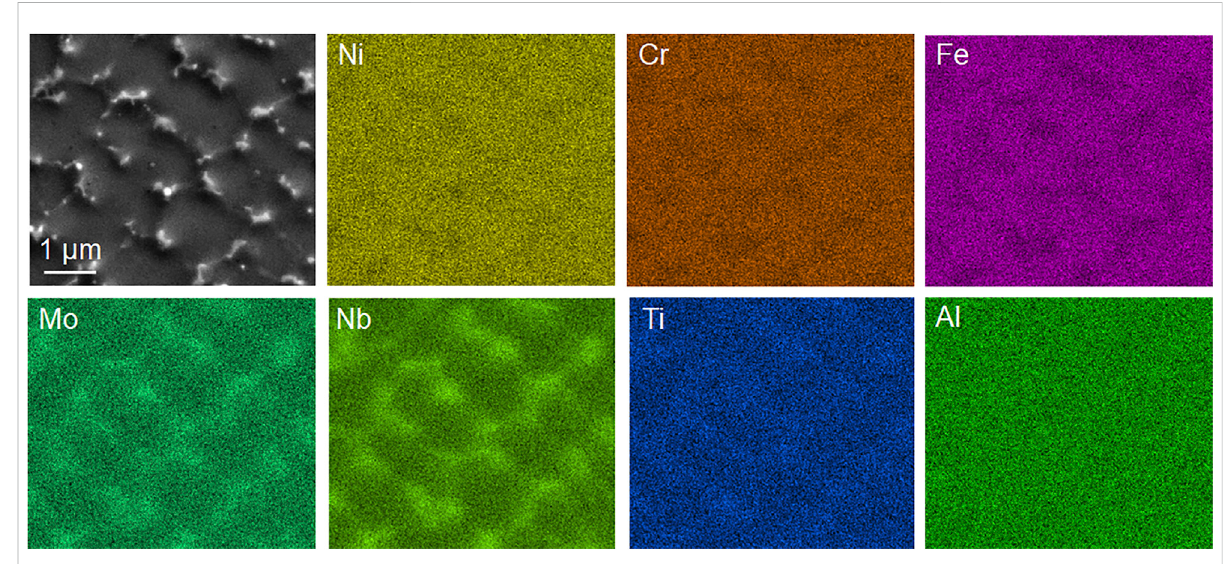
FIGURE 4 SEM-EDS maps of solutes in cellular substructures of as-built Inconel 718 sample.